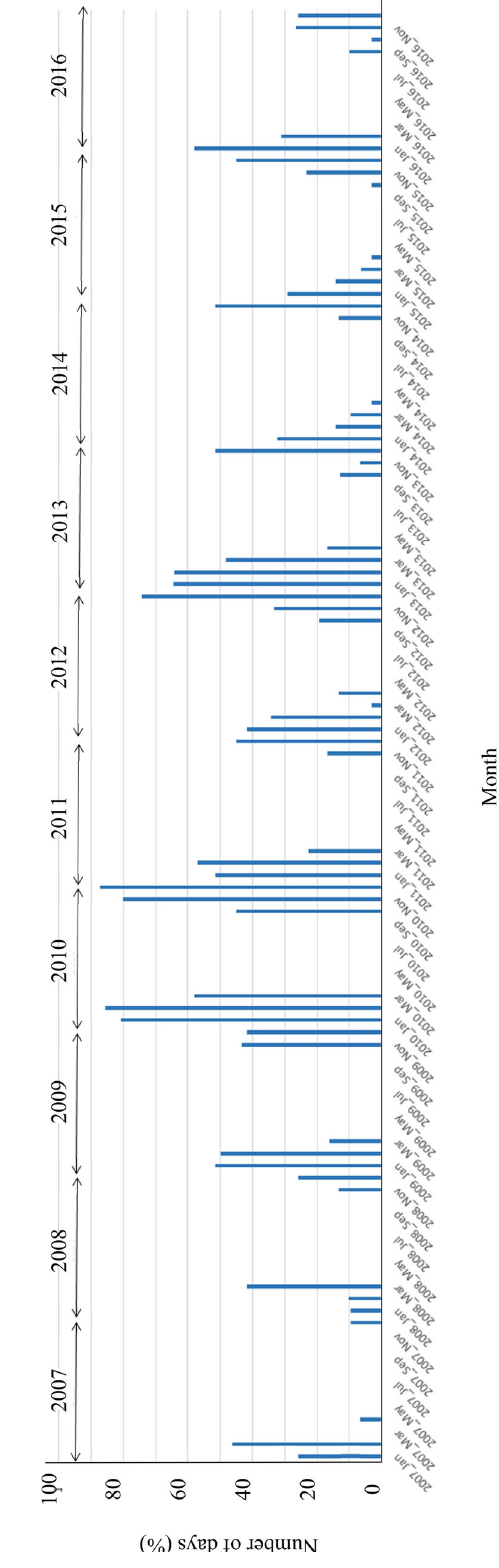
Fig. 5 Punctuality per month for passenger trains in Nordland railway (section between Trondheim and Bodø) from 2007 to 2016